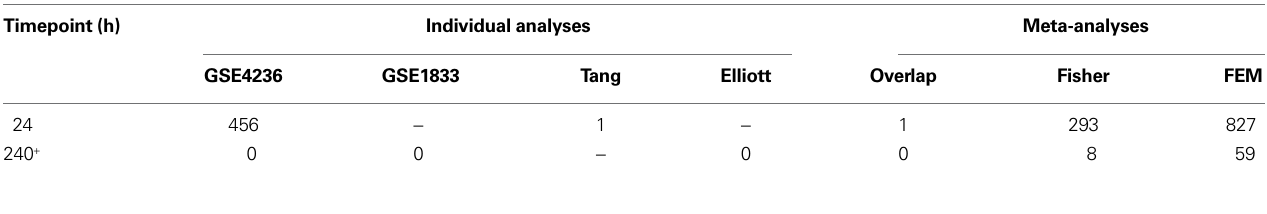
Table 2 | The number of genes found to be differentially expressed in each analysis. The change in expression was considered signifi cant if q -value < 0.05. The overlap method identifi es genes that have been found signifi cant in all of the considered studies. Dashes indicate that a dataset has not been used for a particular